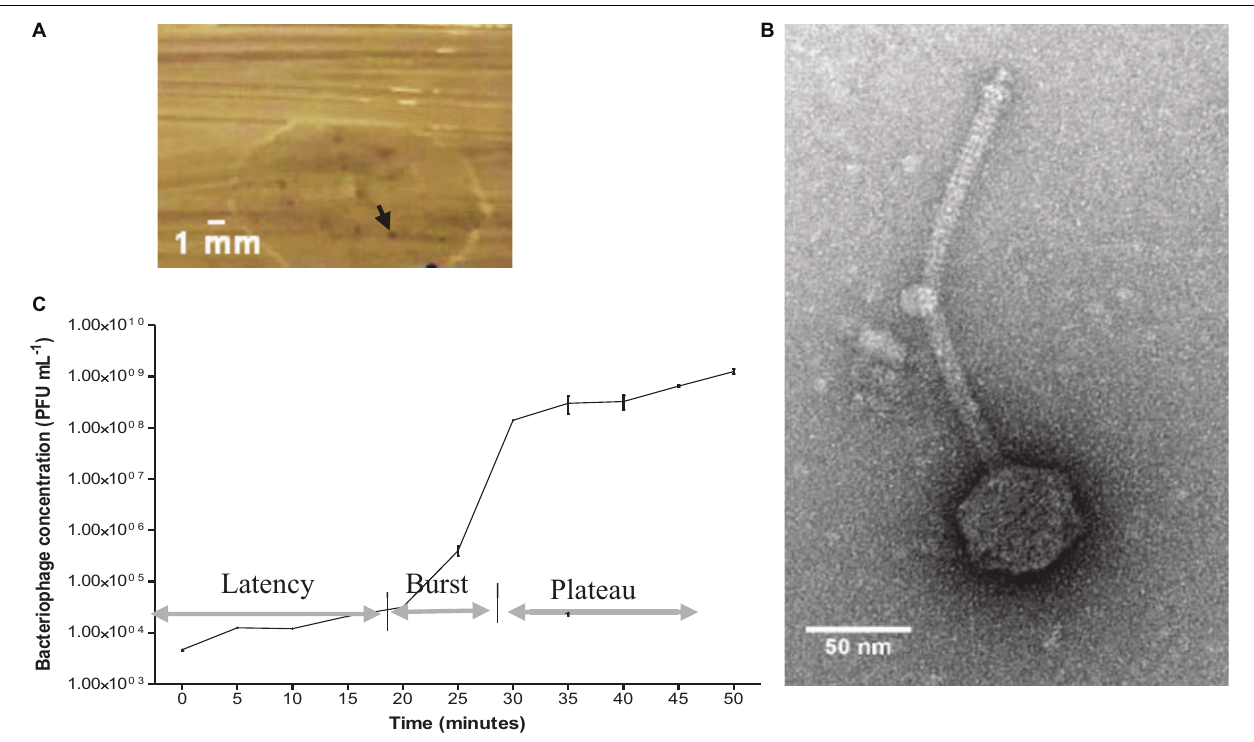
FIGURE 1 | EFA1 plaque morphology, TEM image and growth kinetics. Pin prick plaques with diameter approximately 0.3 mm on E. faecalis host (A) . TEM revealed Siphoviridae morphology with capsid diameter of 58 ± 3 nm and tail length of 223 ± 7 nm (B) . EFA1 OSGC: latent phase of 20 min; burst lasting 10 min; plateau phase occurs after approximately 30 min (C)